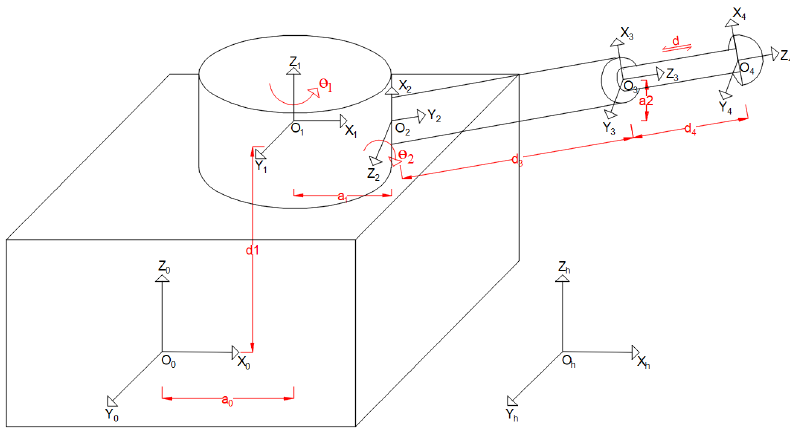
Figure 1. Space pose model of roadheader.